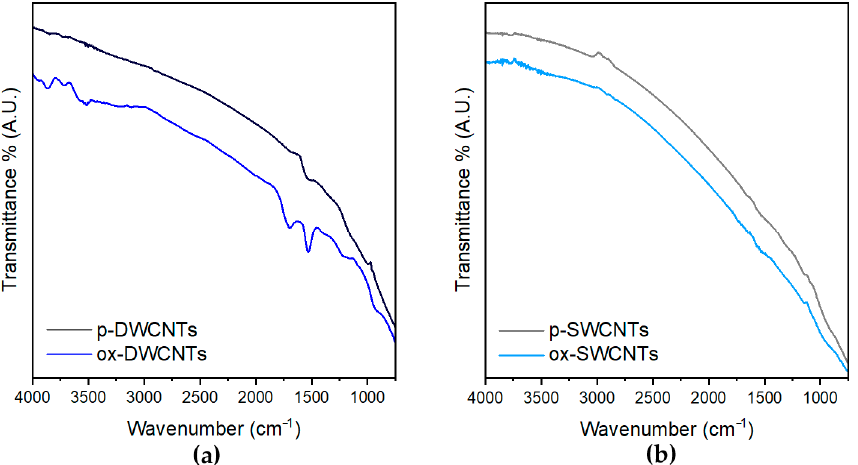
Figure 5. FT-IR spectra of pristine (p-) and oxidized (ox-) CNTs: ( a ) DWCNTs; ( b ) SWCNTs.